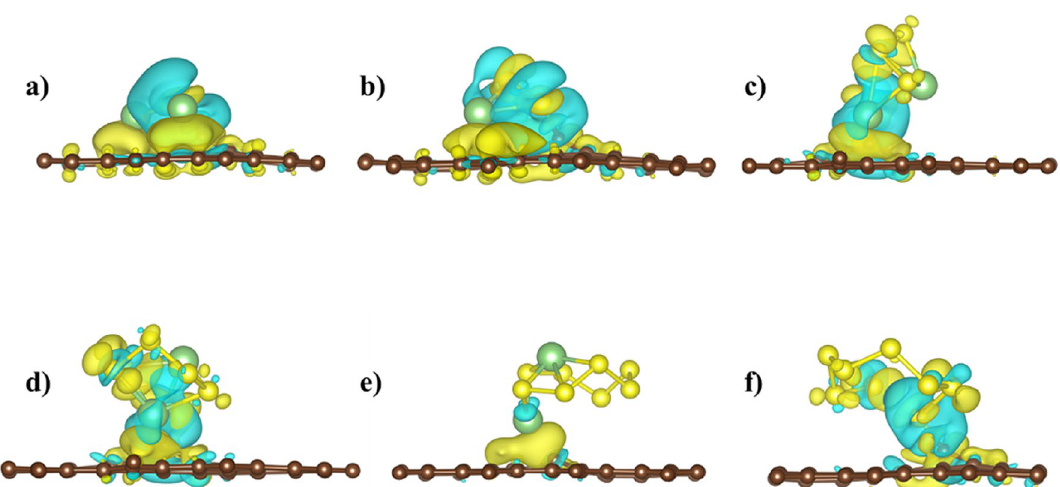
Figure 6. Calculated charge density difference of defective BPN sheet (D2 site) adsorbed with ( a ) Li 2 S, ( b ) Li 2 S 2 , ( c ) Li 2 S 4 , ( d ) Li 2 S 6 , ( e ) Li 2 S 8 , and ( f ) S 8 . Yellow and blue regions indicate charge accumulation and depletion, respectively, the iso-surface value is 0.002 e/A 3 . The brown, green, and yellow spheres correspond to C, Li, and S atoms,